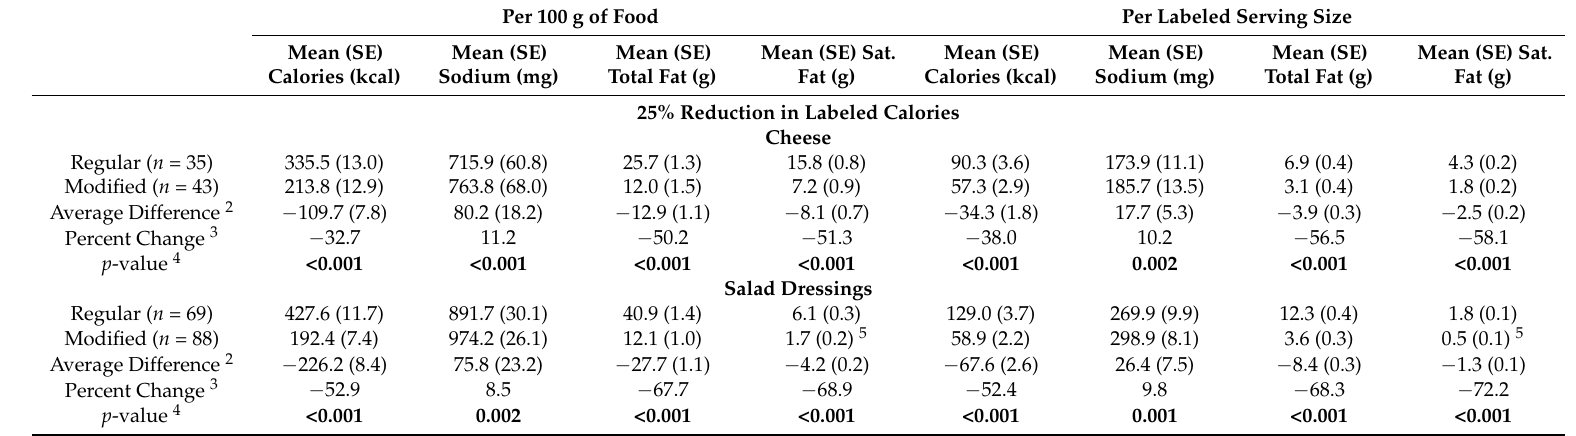
Table 3. Mean calorie, sodium, total fat, and saturated fat by food category for regular and modified foods of matches where the modified food had at least a 25% reduction in labeled calories and/or fat 1